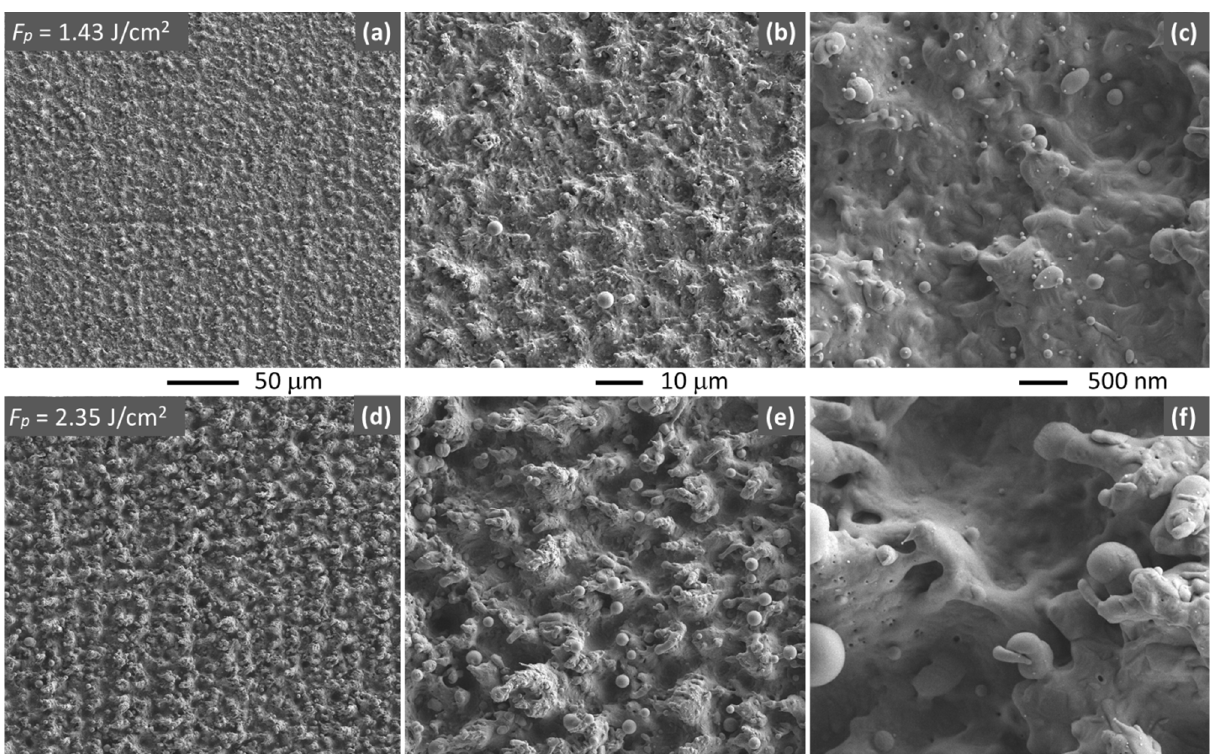
Figure 3. SEM images (secondary electrons) of the copper surfaces processed by laser with LSM at two different pulse fluences: ( a – c ) F p = 1.43 J/cm 2 , ( d – f ) F p = 2.35 J/cm 2 , with different magnification values.